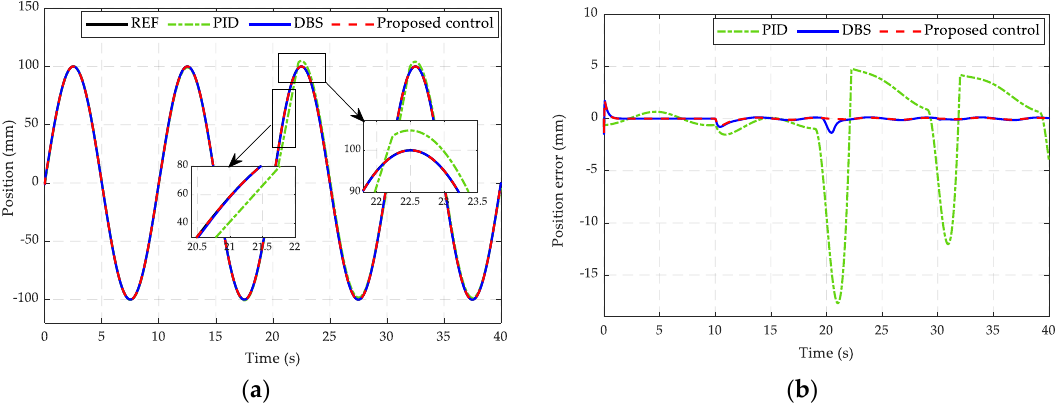
Figure 8. Comparison of sinusoidal trajectory and external loading condition. ( a ) Position-tracking performance. ( b ) Position error effort.